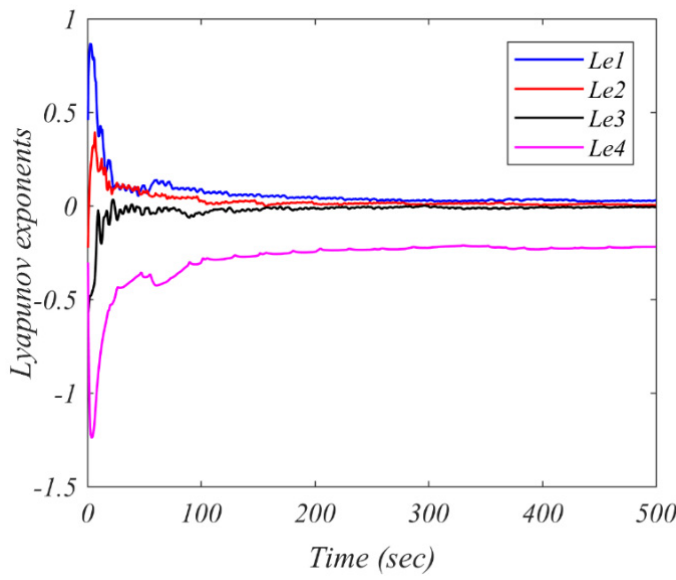
Figure 11. Lyapunov exponents in contradiction of time.